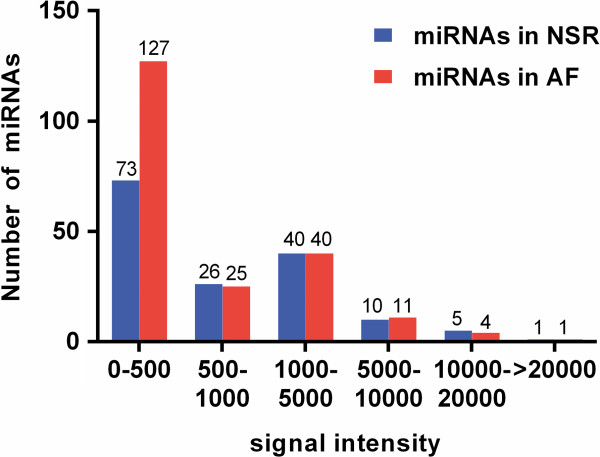
Signal distribution of all detected miRNAs in MS patients, shown by microarray assay. The signal intensities of most of these miRNAs were low (0–500 units), with only 11 miRNAs showing intensities greater than 10000 units.